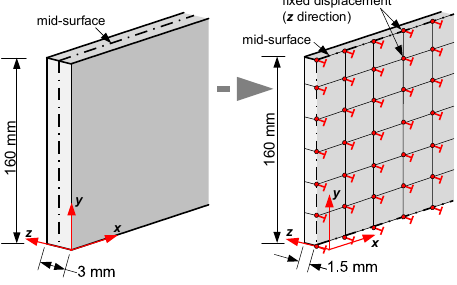
Figure 12. Symmetry conditions applied in the bridge Model-3 .